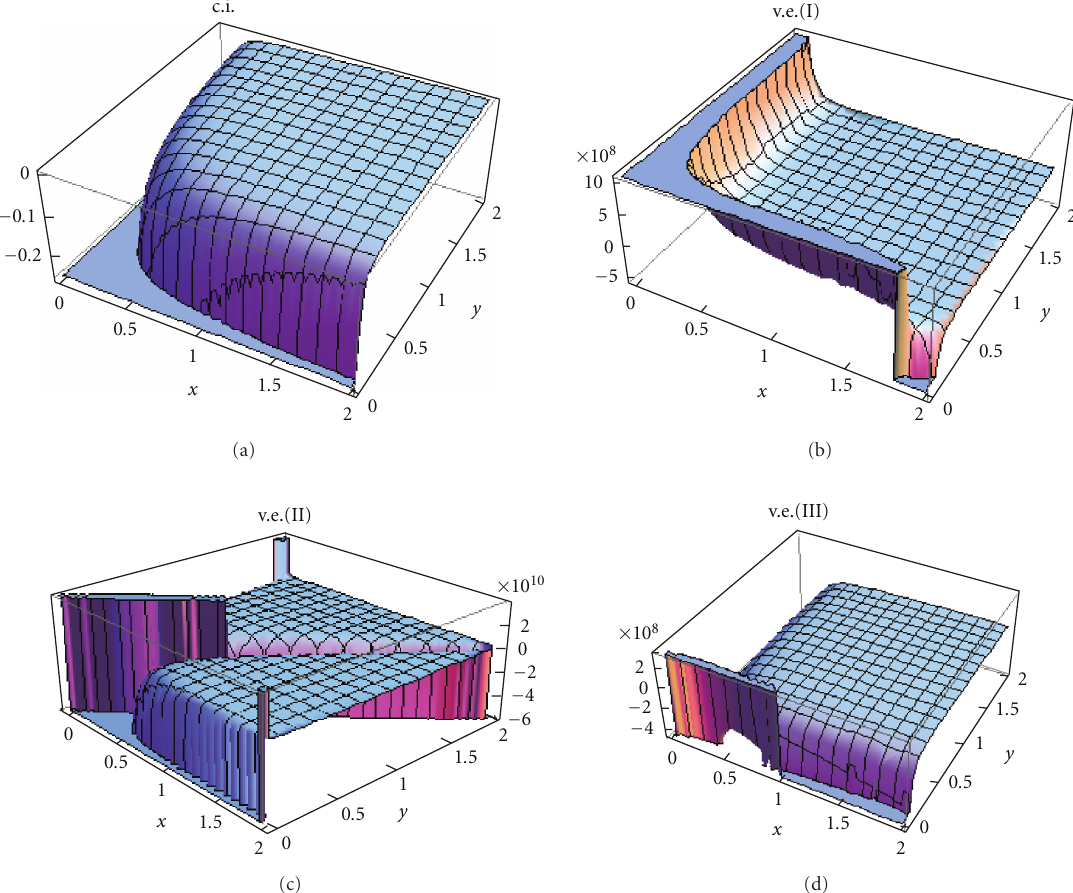
Figure 5: Plots of the contact interaction and of the vector-exchange contributions in the specialized planar configuration (plus sign).